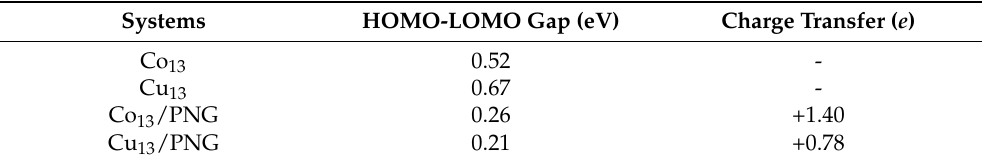
Table 1. Charge transfers and HOMO-LOMO gaps for Co 13 , Cu 13 , Co 13 /PNG, and Cu 13 /PNG. The positive values indicate charge transfers from the nanoclusters to the PNG structure.